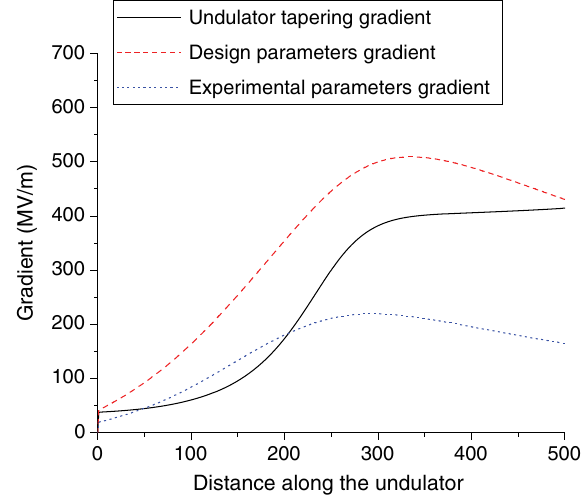
FIG. 4. Ponderomotive gradient using design parameters from Table I and gradient from the undulator resonance condition. The experimental case corresponds to a laser pulse with 50% lower intensity due to losses in the optical transport and with significant higher order modal content (M2 factor ¼ 1 . 6 ).